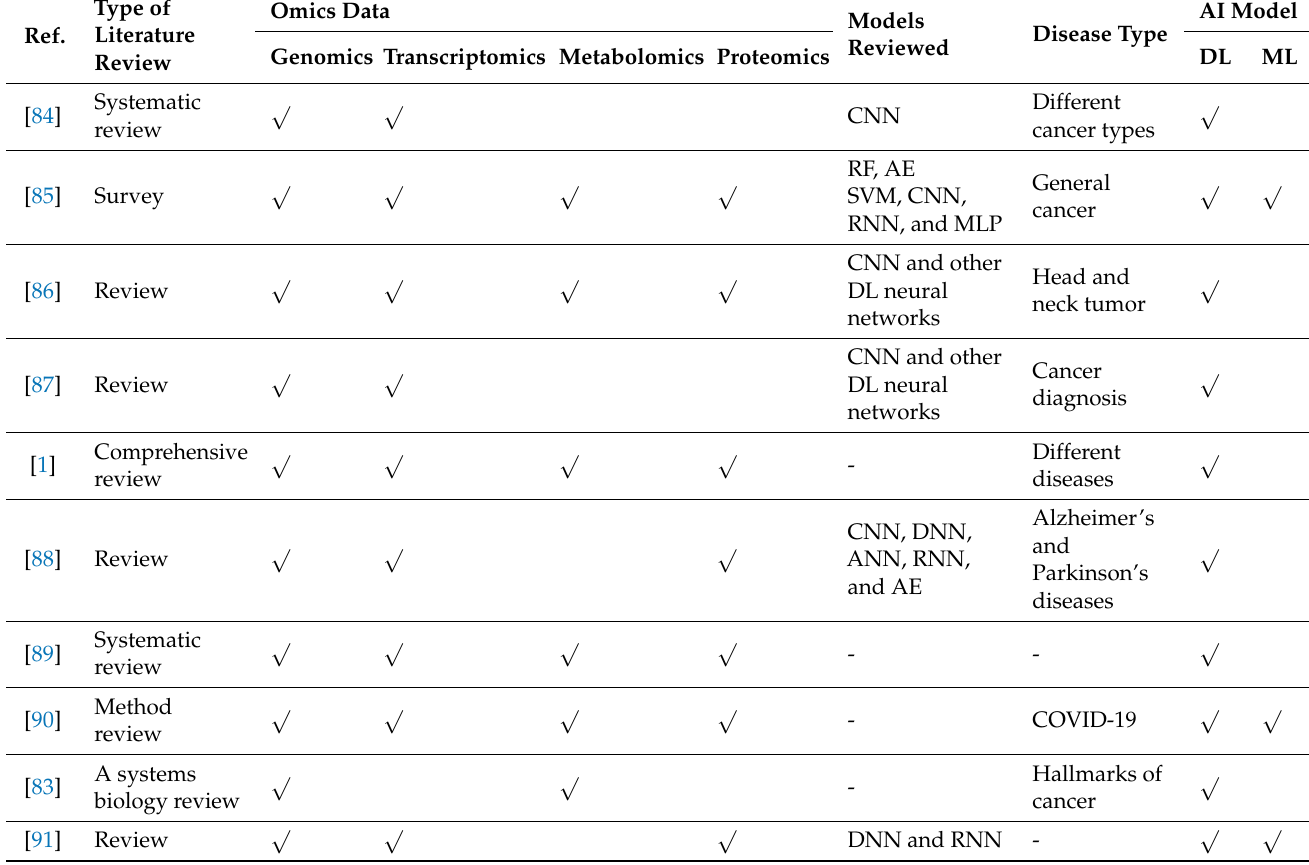
Table 4. Review and survey articles in the multi-omics